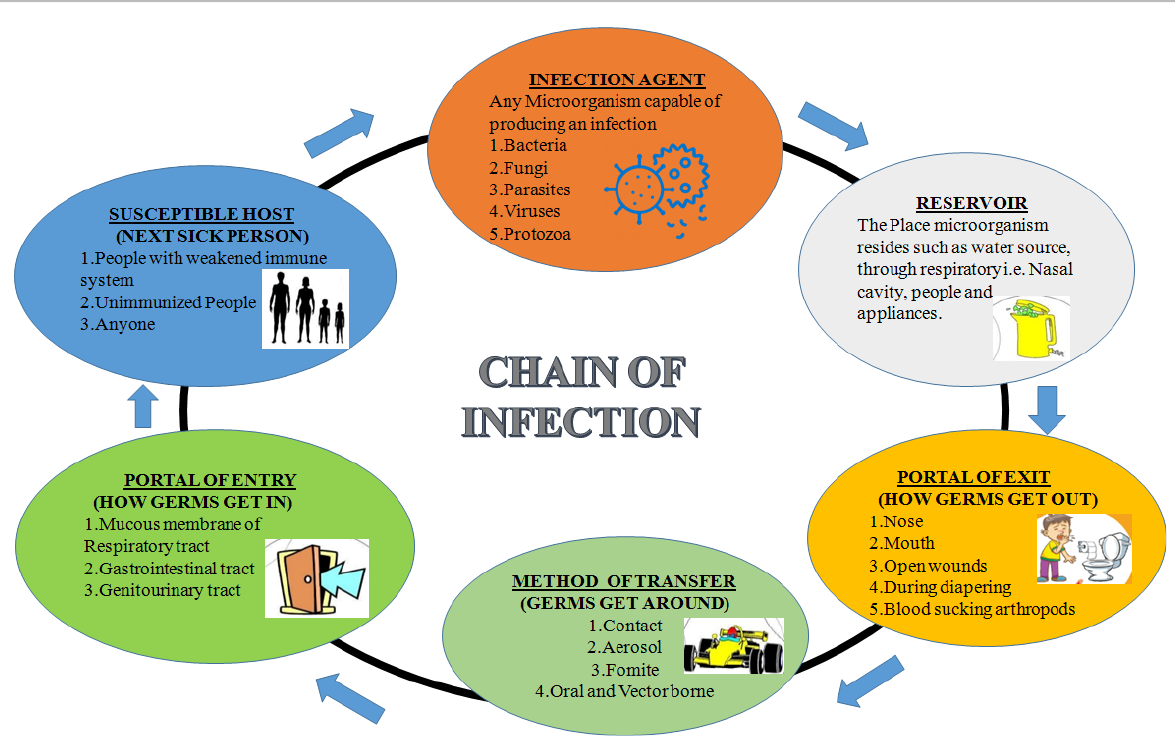
FIGURE 3 - Chain of